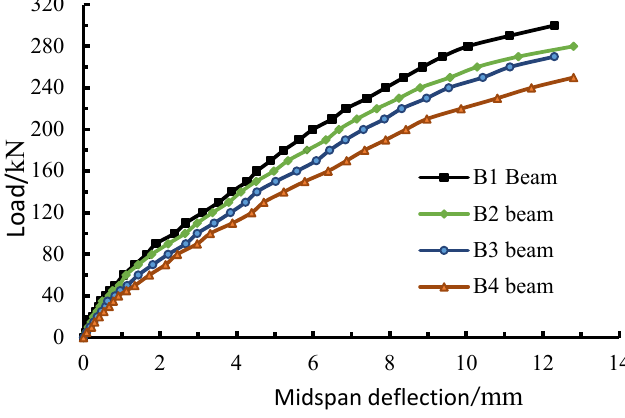
Figure 5. Load–midspan deflection curves.